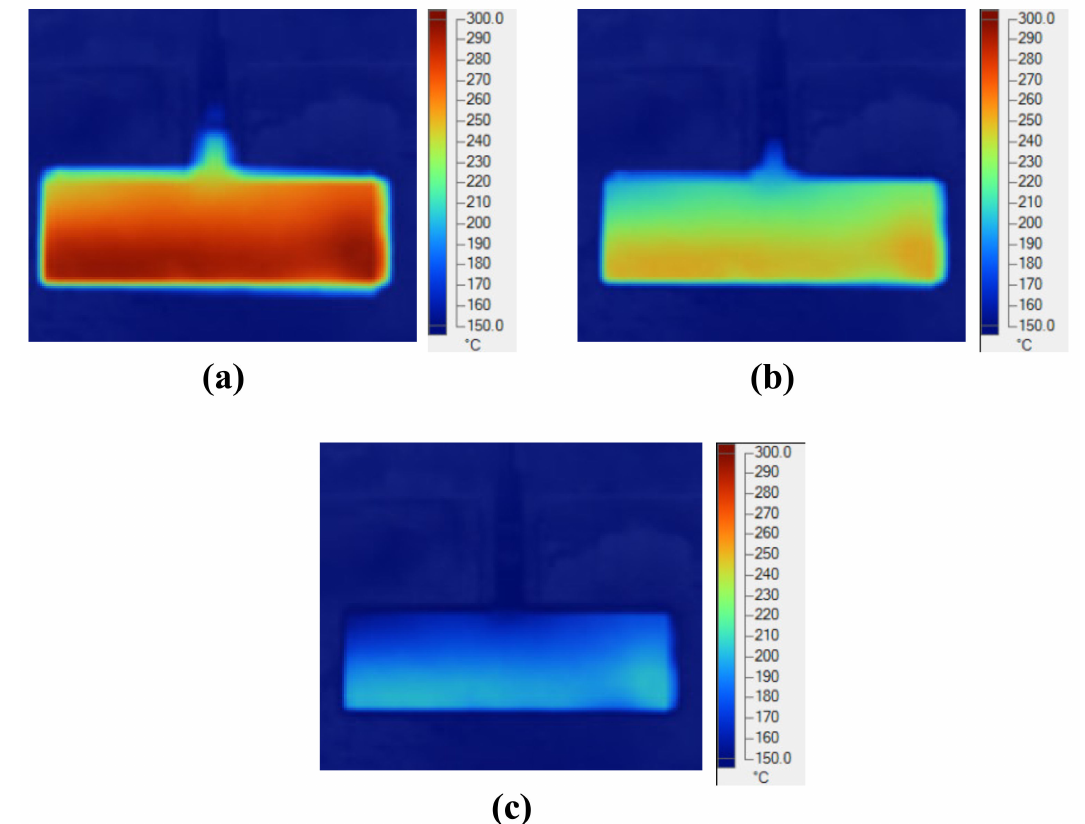
Figure 13. Measured temperature distribution of cavity plate after 5 s heating with the gap (G) of ( a ) 5; ( b ) 10; and ( c ) 15